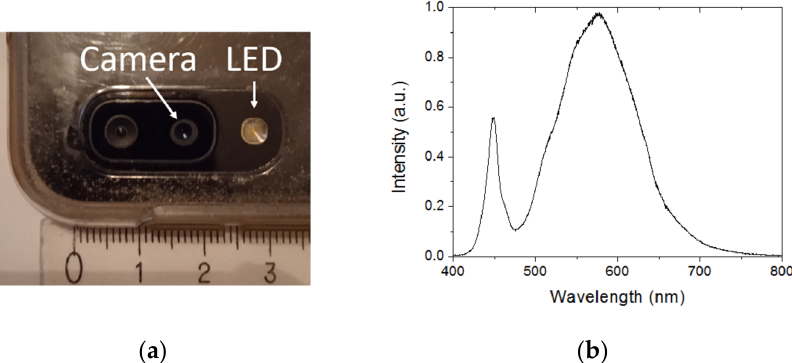
Figure 2. ( a ) Smartphone built-in LED flashlight and camera used in the proposed refractometric optosensing platform. The smallest division of ruler equals 1 mm. ( b ) Spectral emission of the smartphone LED flashlight.